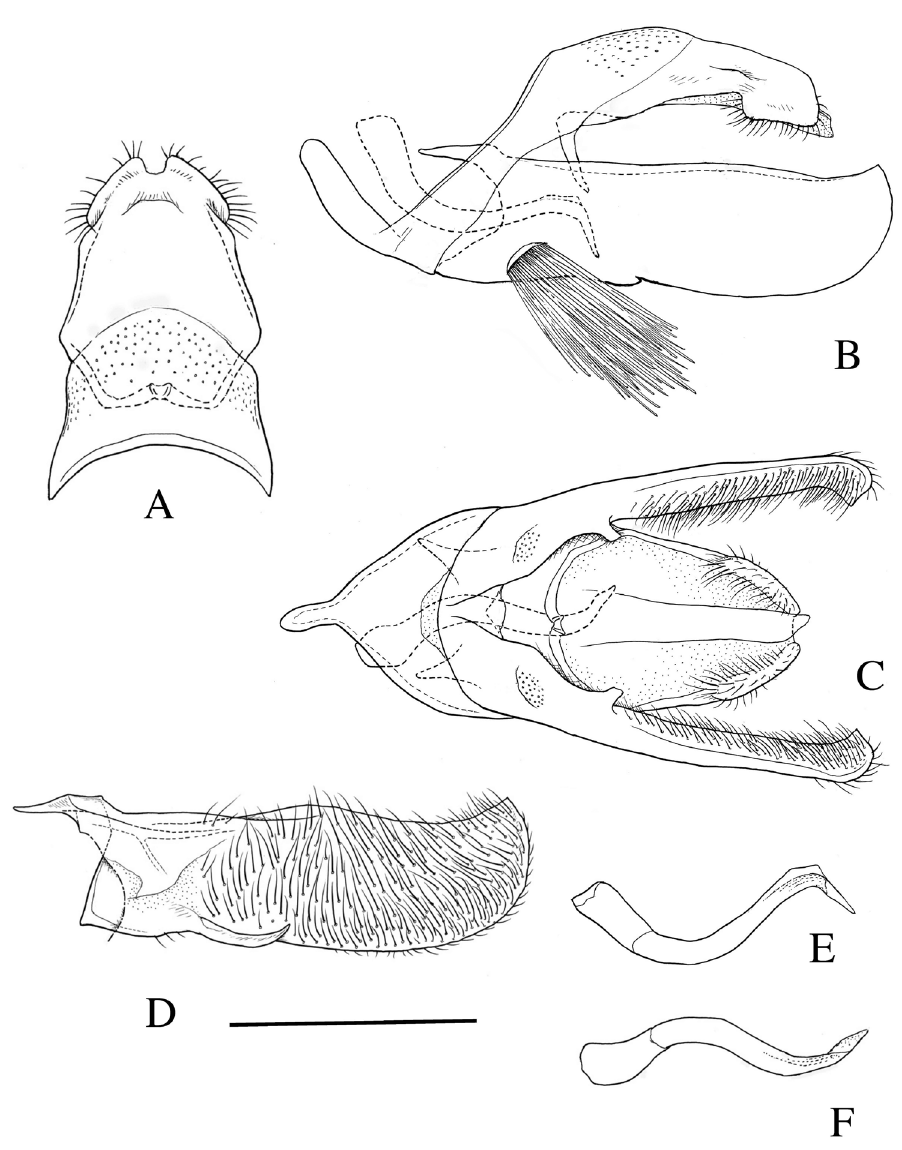
Figure 2. Male genitalia of Roeslerstammia metaplastica Meyrick, 1921, lectotype. A Dorsum (uncus and tegumen), dorsal view B Genitalia without phallus, lateral view C Ditto ventral view D Right valva, inner view E Phallus, lateral view F Ditto, dorsal view. Scale bar: 0.5